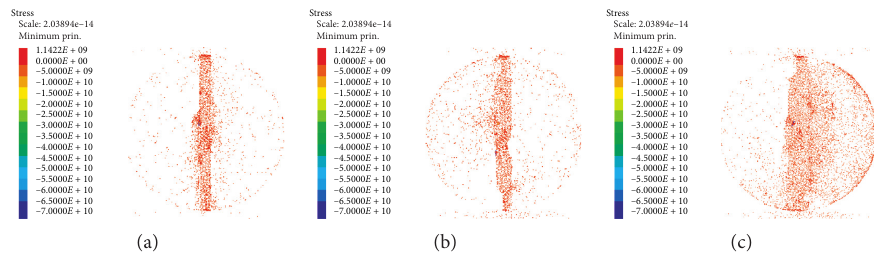
Figure 19: Loaded stress cloud of uniform parallel bedding models with different layer thicknesses. (a) 3.6mm. (b) 5.0mm. (c) 7.1mm. Stress Scale: 3.92752e–14 Minimum Prin.